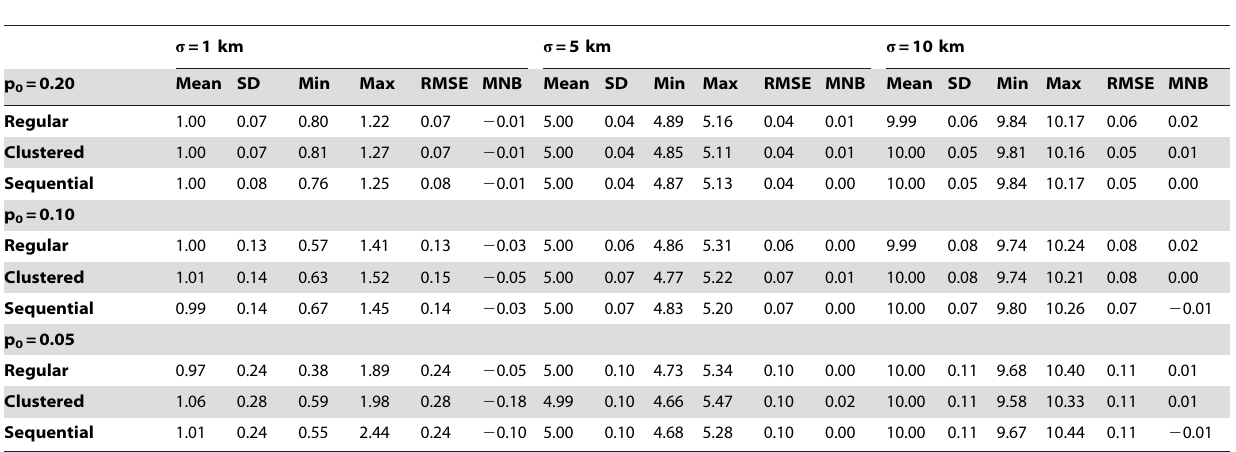
Table 4. Summary estimates of ^ ss when the true population size N=500 and J =128 traps, under each of the three trap arrangements: regular, clustered, and sequential, where mean, standard deviation (SD), range, root mean squared error (RMSE), and mean normalized bias (MNB) are given for each scenario ( p x s x configuration) .